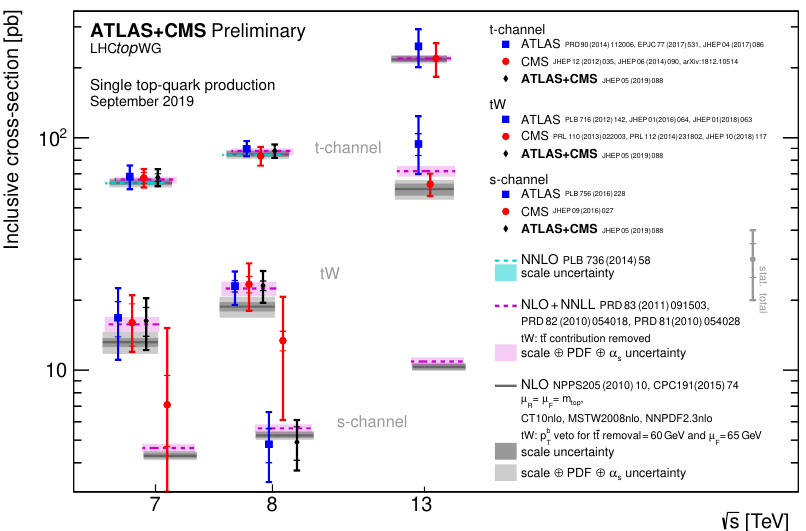
Figure 6 . Summary of the available single-top production cross-section measurements from the LHC